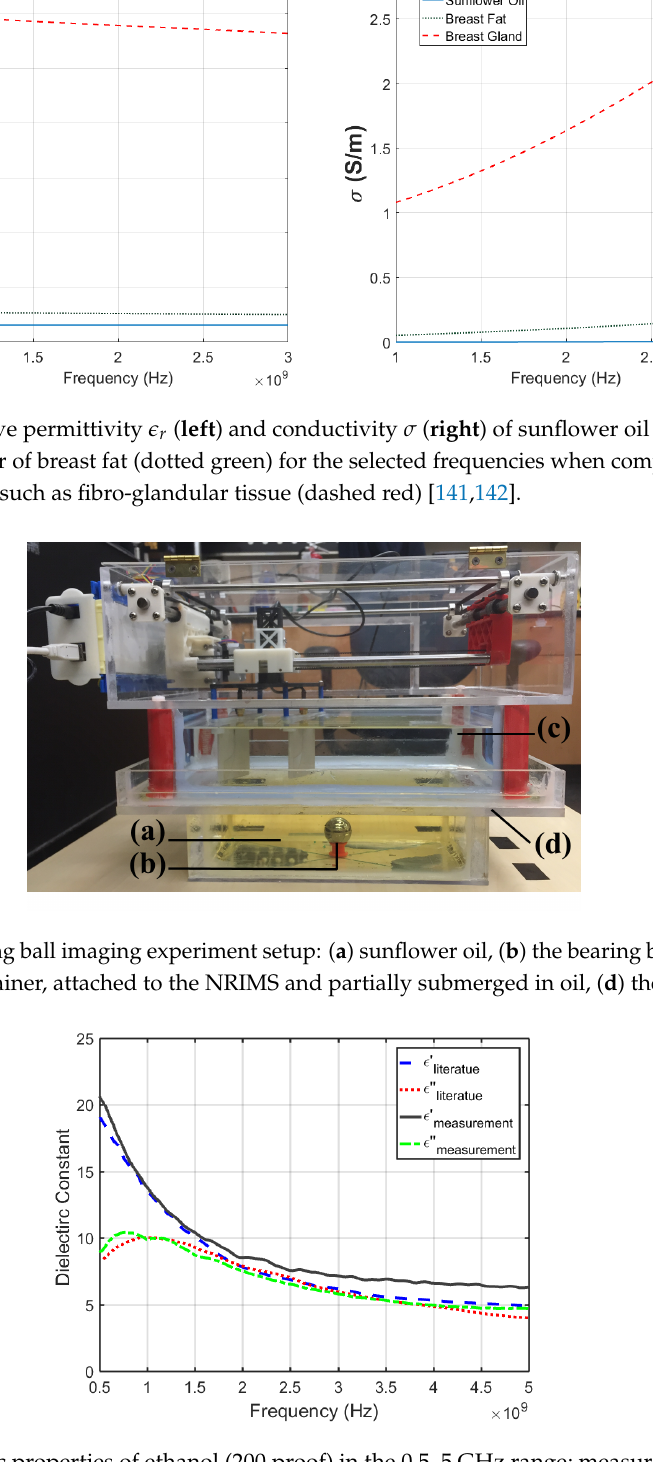
Figure 10. Dielectric properties of ethanol (200 proof) in the 0.5–5 GHz range; measured versus what has been reported in the literature [125]. (cid:101) (cid:48) and (cid:101) (cid:48)(cid:48) denote the real and imaginary part of the complex relative permittivity,